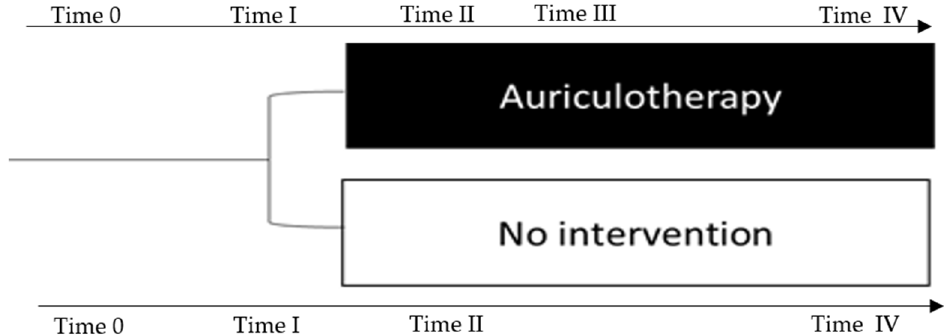
Figure 3. Timeline of the study session. TP 0: Screening and baseline period (one month before exam) outcome: State Anxiety inventory. TP I: morning (7.30 a.m.) 1 day before exam (outcome: sleep quality and salivary cortisol). TP II: Before (11 a.m.) AA (outcome: State Anxiety inventory, visual analogue scale, sleep quality, and salivary cortisol). TP III: 30 min after AA (outcome: State Anxiety inventory, visual analogue scale, and salivary cortisol). TP IV: morning (7.30 a.m.) before examination (outcome: State Anxiety inventory, visual analogue scale, sleep quality, and salivary cortisol).